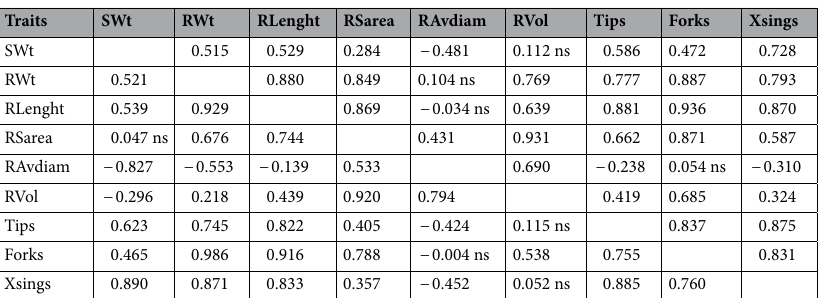
Table 3. The genetic correlations (lower triangle) and phenotypic correlations (upper triangle) of eight root trait and one shoot trait under low N-management. SWt, shoot weight, RWt, root weight, RLength, root length, RSarea, root surface area, RAVdiam, root average diameter, RVol, root volume, Tips, number of root tips, Forks, number of forks, Xsings, number of crossings, ns, not significant at P ≤ 0.05; all others, significant at 0.05 > p <